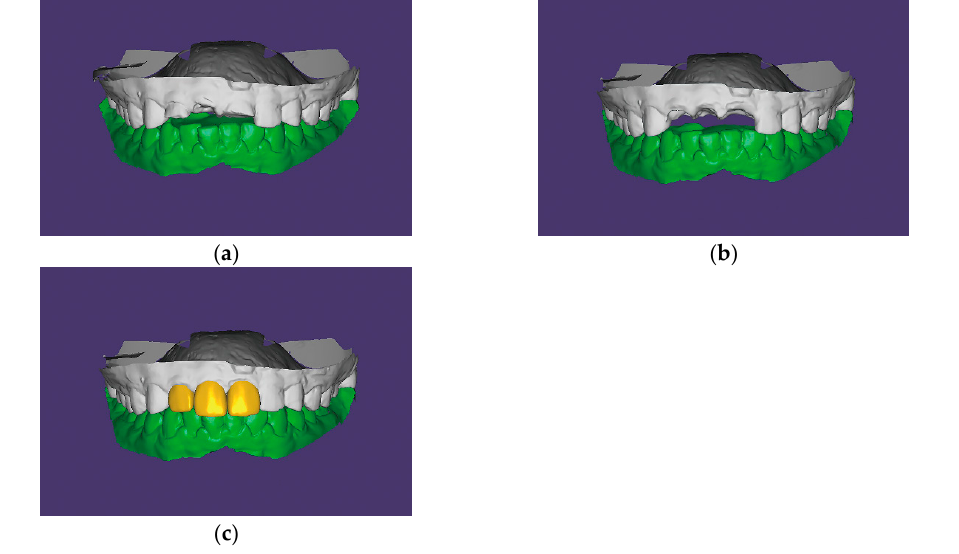
Figure 2. Diagnostic virtual tooth arrangement procedures in CAD software (Exocad DentalCAD version 2015.03, Exocad GmbH, Darmstadt, Germany); ( a ) Maxillary and mandibular diagnostic casts scanned with a tabletop scanner (Identica Blue, Medit Co., Seoul, Korea); ( b ) Modification of the sites planned for rehabilitation; ( c ) Design of the virtual teeth on the modified maxillary diagnostic cast. CAD, computer-aided design.